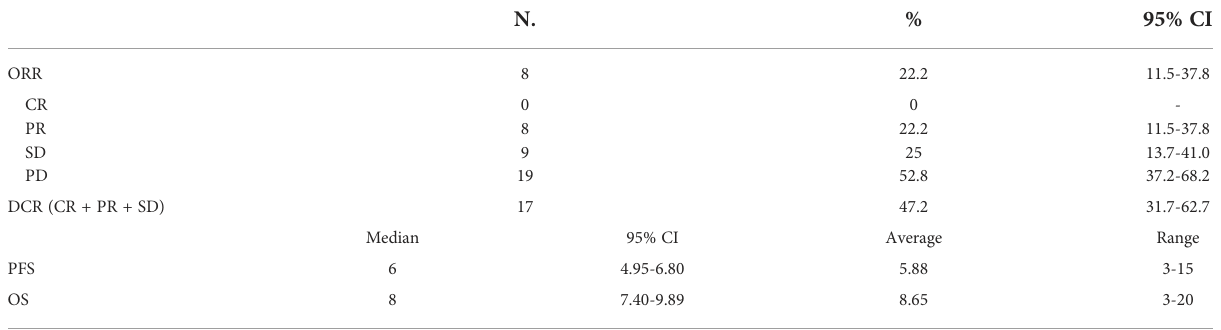
TABLE 3 Summary of treatment activity and ef fi cacy.